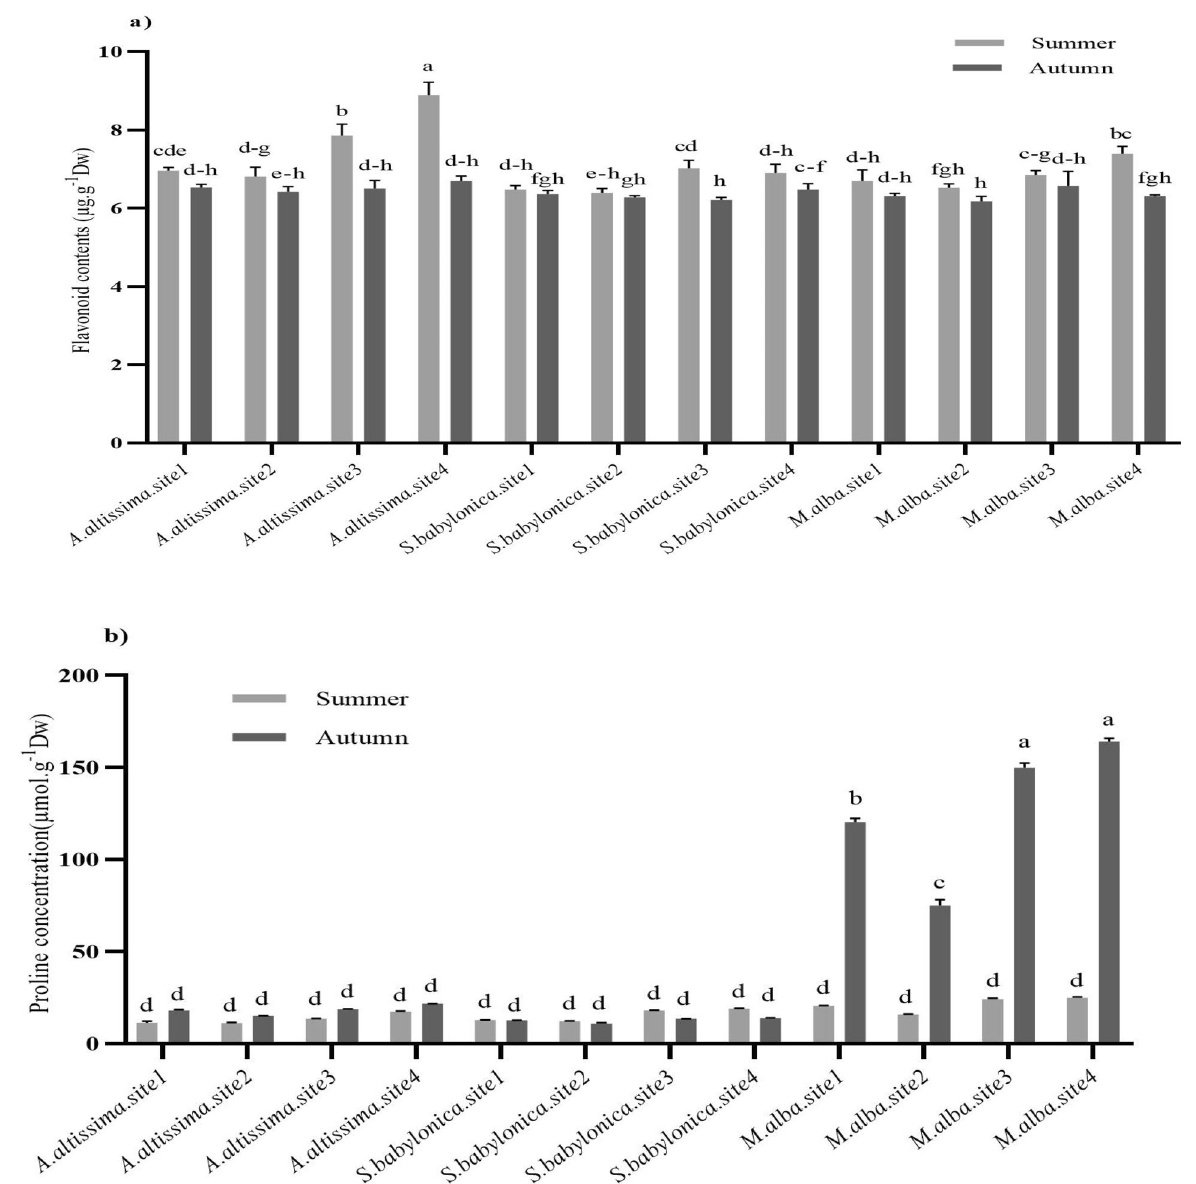
Figure 4. Flavonoid contents ( a ) and proline concentration ( b ) of A. altissima, S. babylonica , and M. alba trees in spring, summer, and autumn at sites 1 (Mirdamad Street), 2 (Mirza Babaei Street), 3 (Kargar Shomali